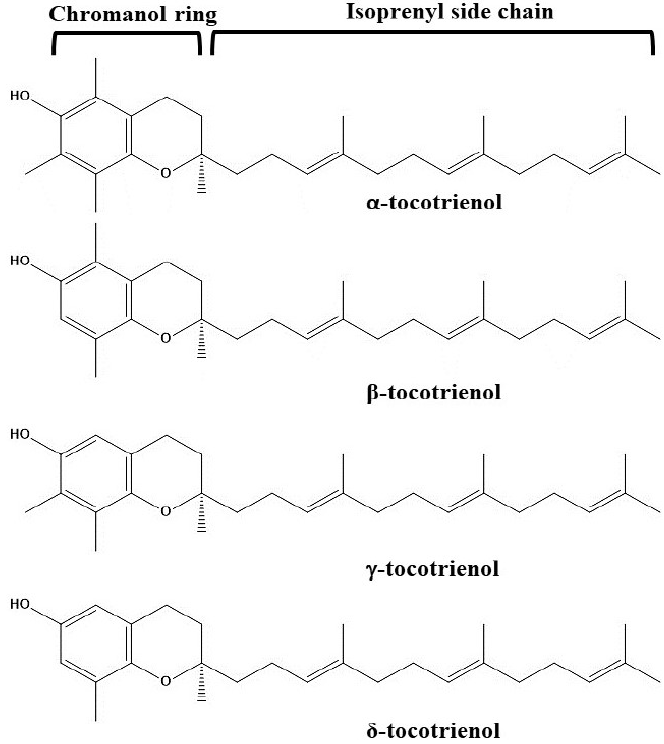
Figure 2. Chemical structures of different forms of tocotrienols.